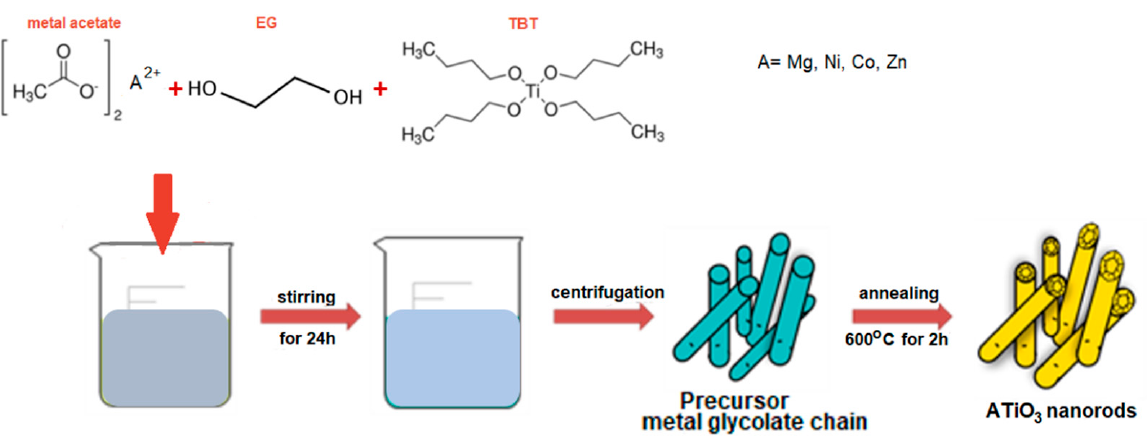
Figure 1. Formation mechanism of metal titanate nanorods ATiO 3 (A = Mg, Co, Ni, Zn).